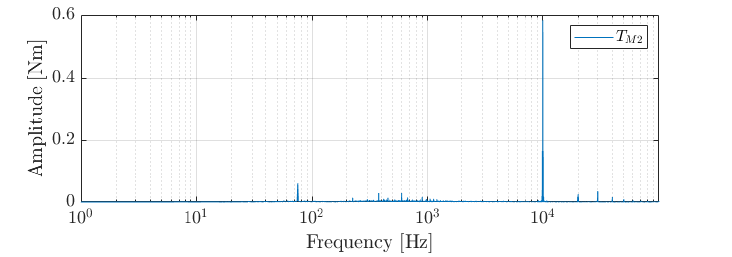
Figure 13. Simulated torque output from motor M2 during the synchronized control modular scenario with a switching frequency of 10